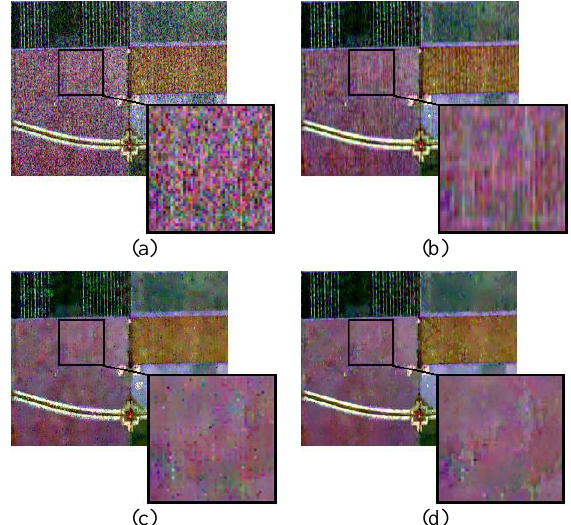
Figure 3. The zoomed area images. (a) speckled data,